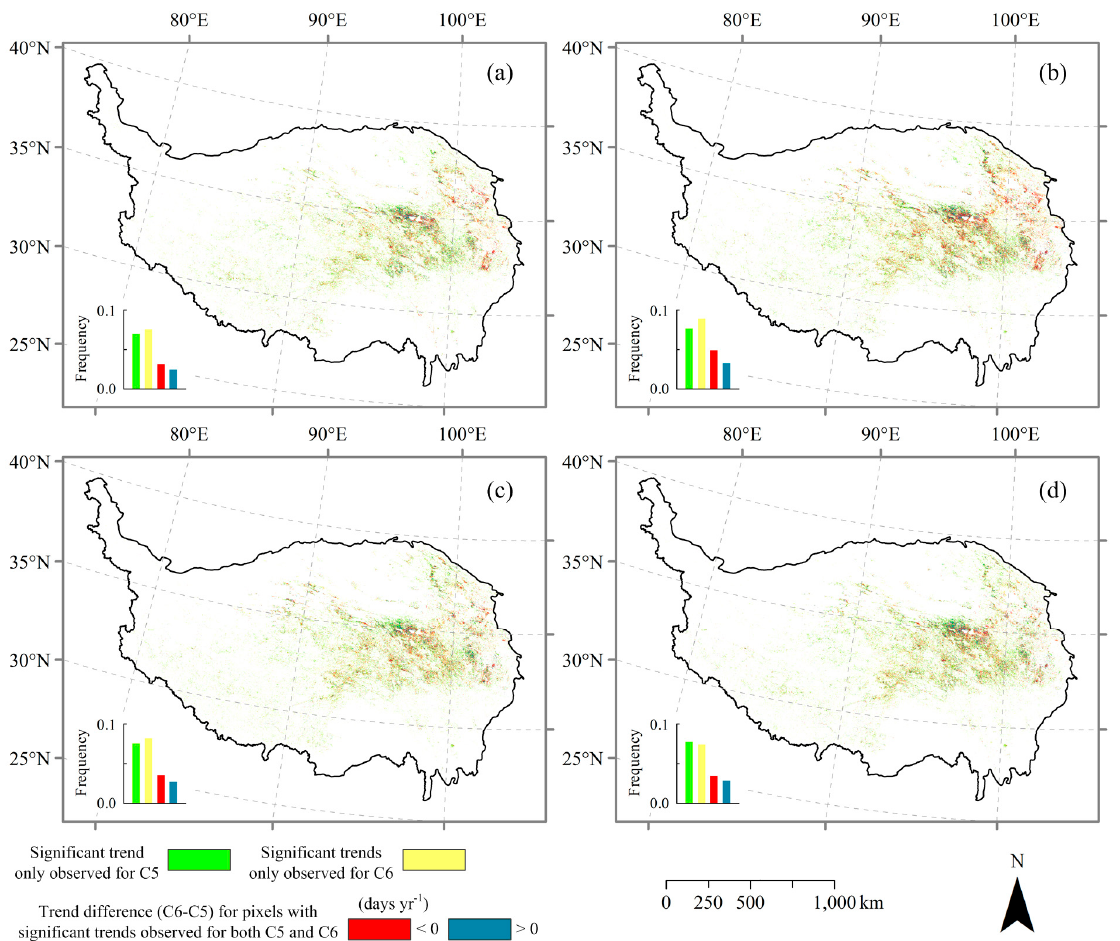
Figure 8. Comparison of trends in start of growing season between C5 (SOS C5 ) and C6 (SOS C6 ) during 2001–2015 for different methods: ( a ) Maximum Curvature Change (MCC); ( b ) Dynamic Threshold 0.2 (DT2); ( c ) Dynamic Threshold 0.5 (DT5); and, ( d ) Maximum Slope (MS).